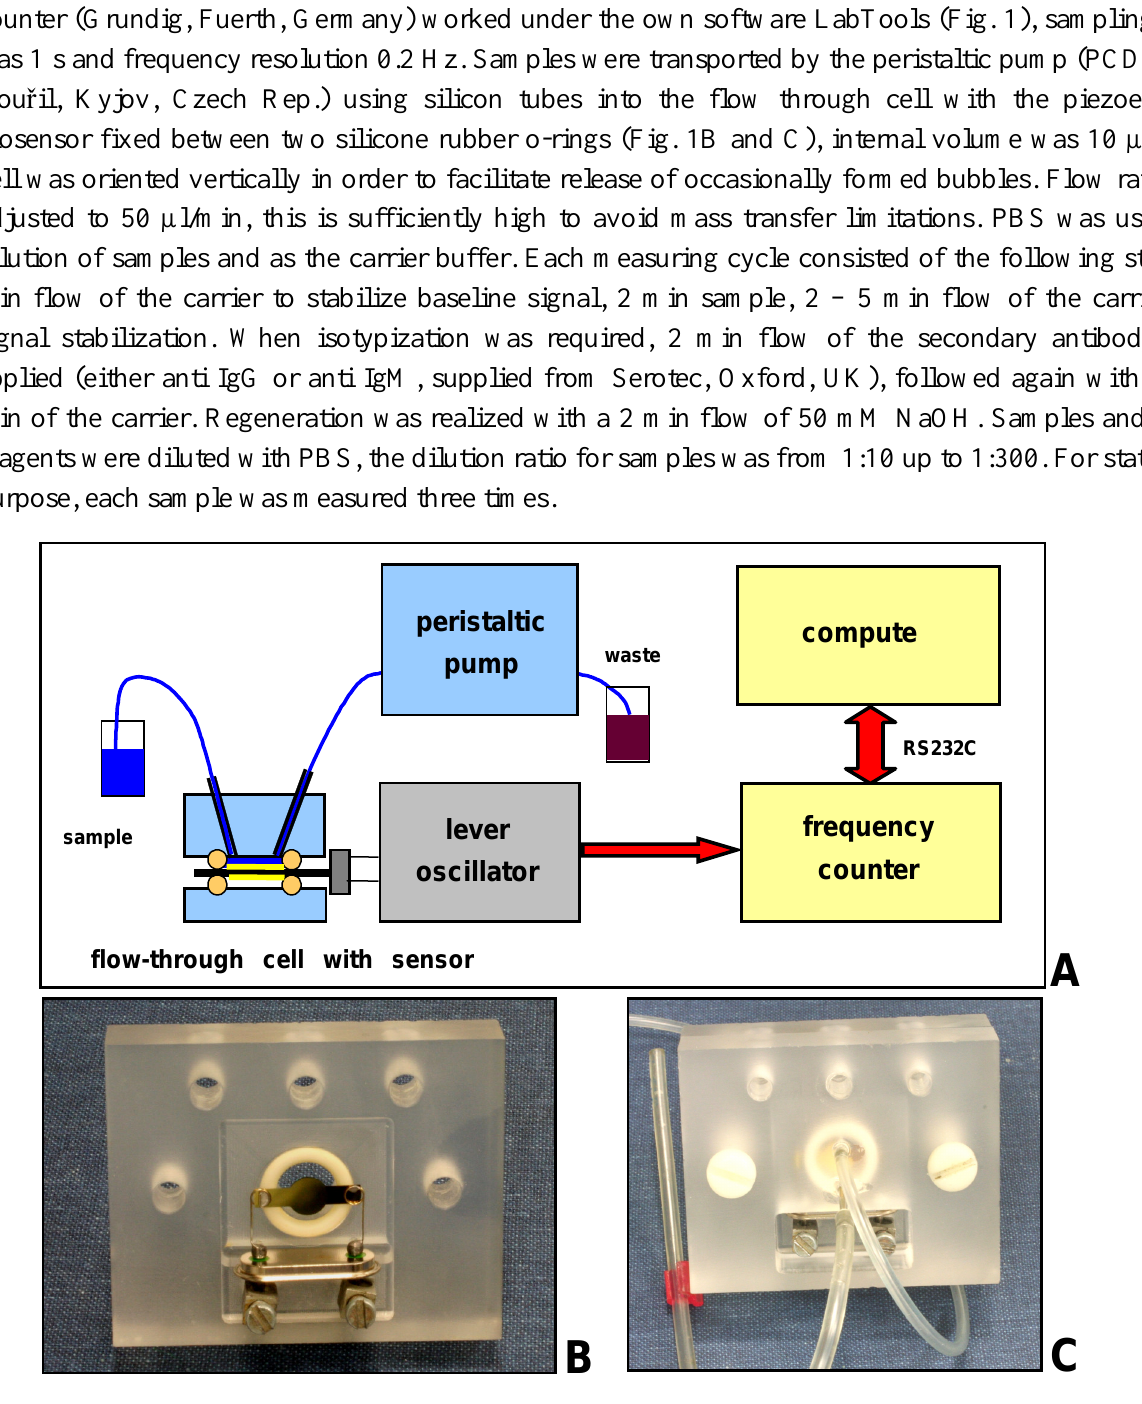
Fig. 1. (A) Schema of the measuring setup consisting of the flow-through cell with the piezoelectric quartz crystal; opened (B) and assembled (C) views. The sensor is driven by the lever oscillator and the output frequency is recorded using a general-purpose counter and continuously transferred to the computer. Flow is realized using the peristaltic